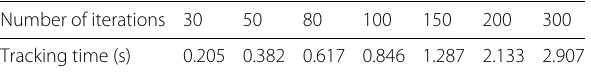
Table 2 Relationship between tracking time and number of